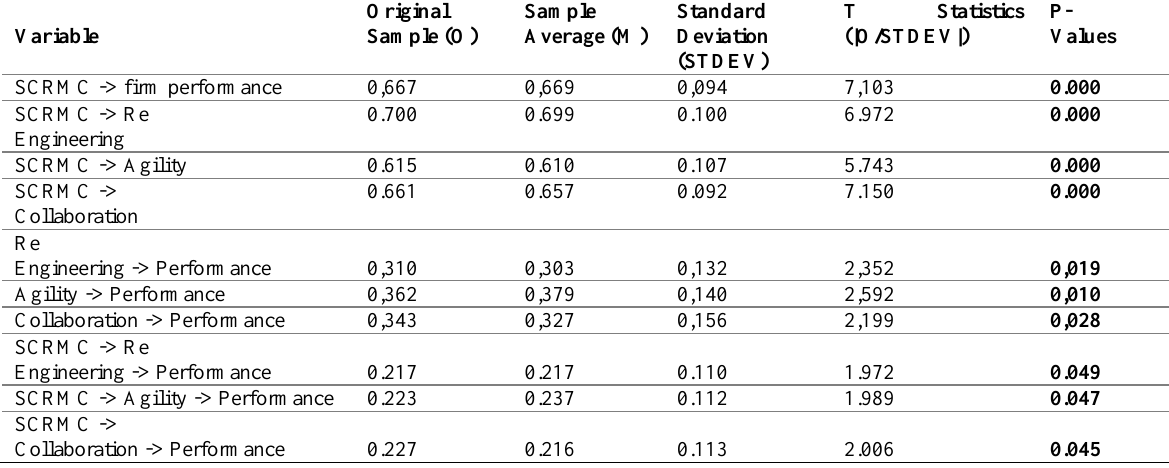
Table 1: Hypothesis